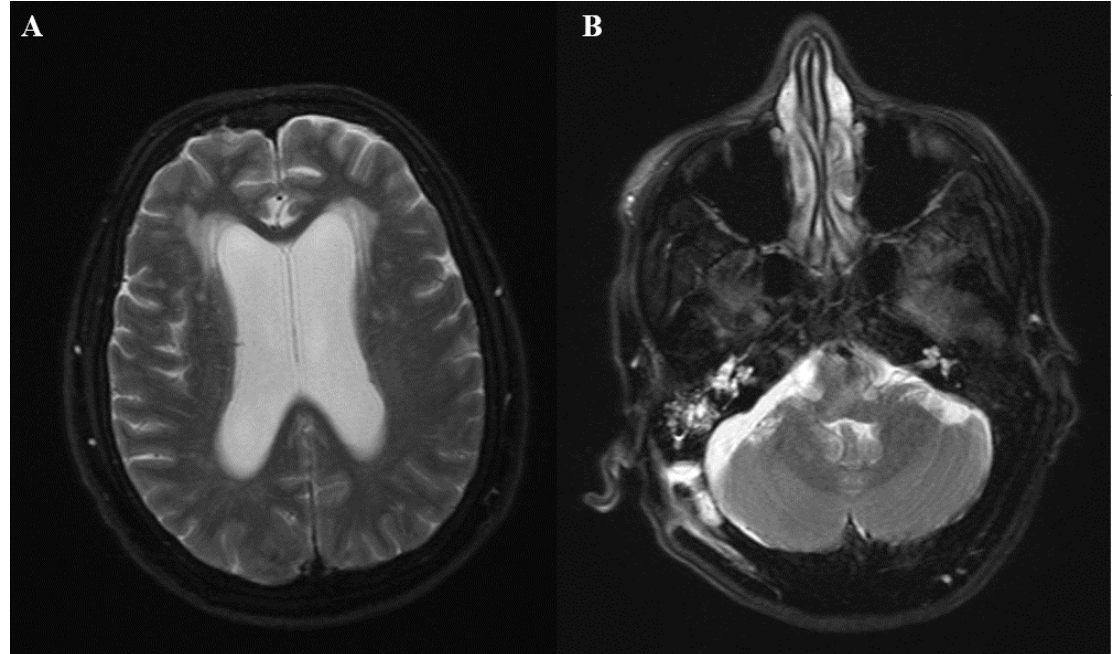
Figure 1. ( A ) Axial T2 ‐ weighted MRI (magnetic resonance imaging)showing diffuse leptomeningeal enhancement and moderately dilated ventricles ( B ) T2 ‐ weighted MRI showing a right cerebellar extra ‐ axial collection of approximately 1 cm in diameter.